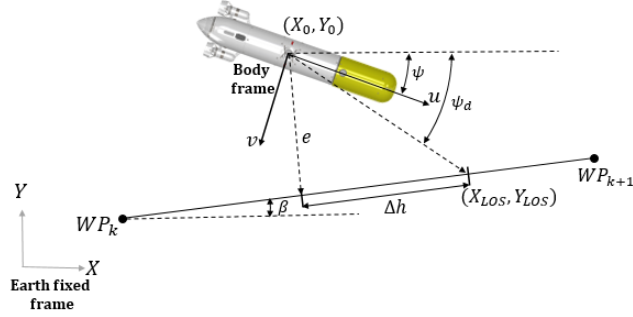
Figure 9. LOS controller